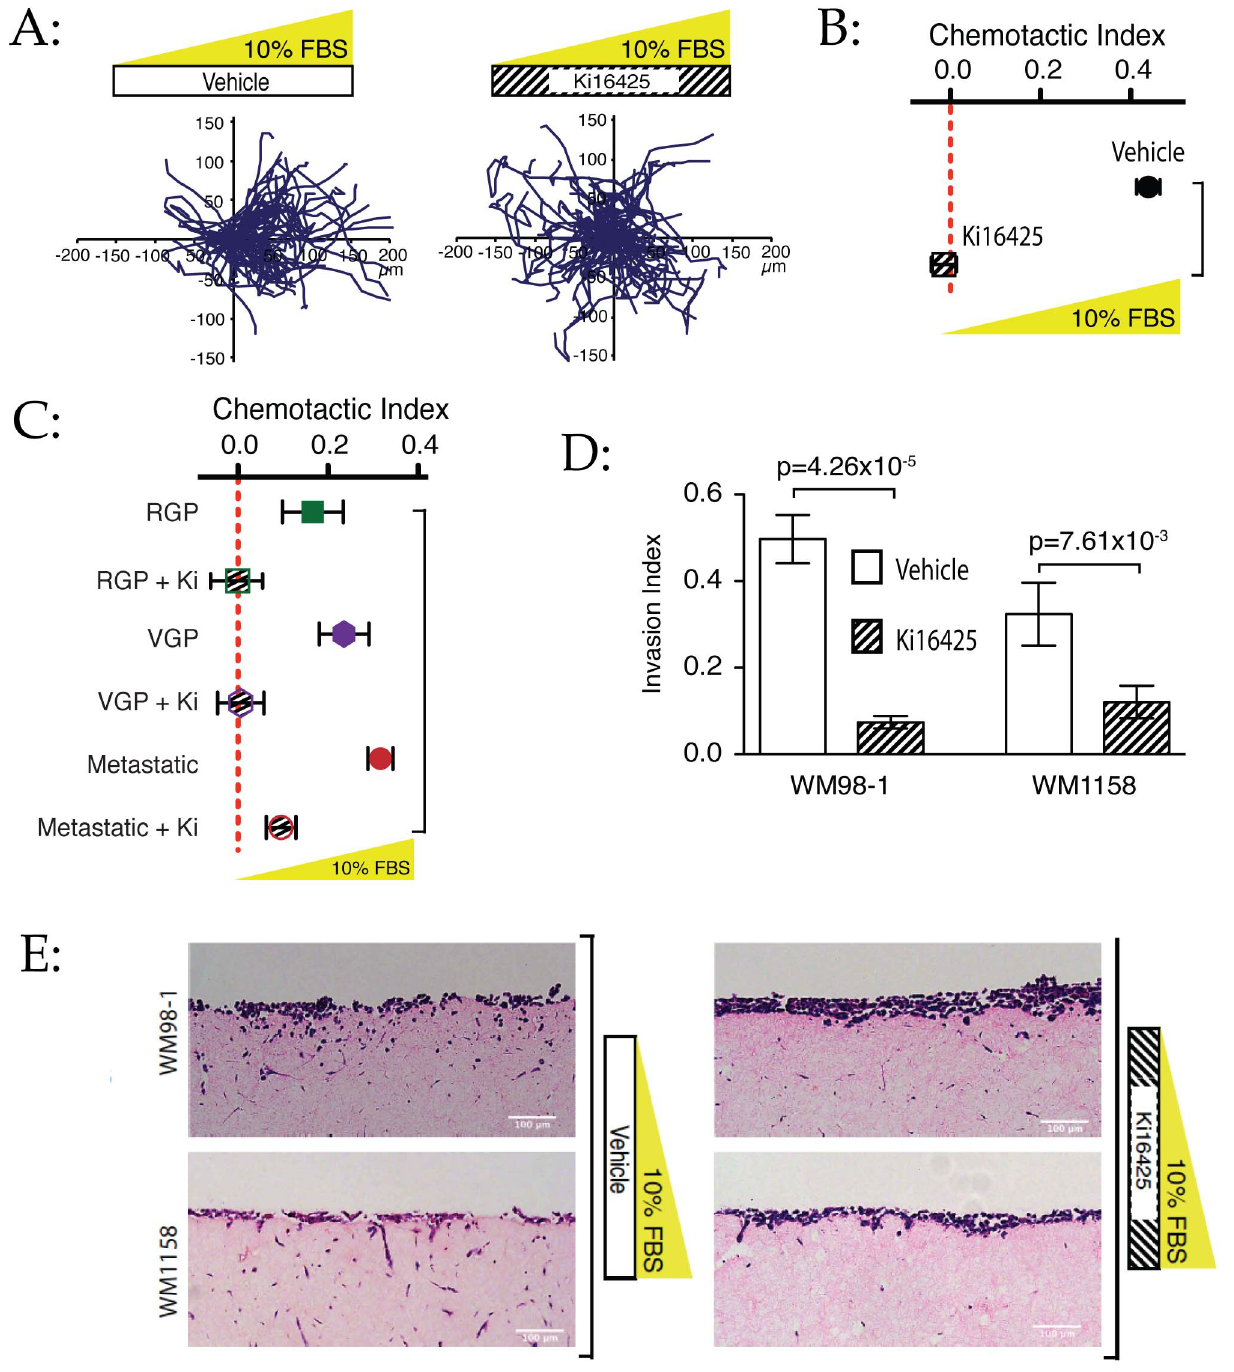
Figure 5. LPA responses are essential for serum chemotaxis in 2-D and 3-D assays. (A) LPA receptor antagonist Ki16425 blocks chemotaxis to serum. Chemotaxis of WM239A cells was compared with and without 10 m M Ki16425. Inhibitor-treated cells showed no chemotaxis despite essentially normal random migration. (B) Quantitative analysis of Ki16425 activity. Data from three experiments, including the one in (A). The chemotactic index of inhibitor-treated cells is essentially zero. (C) Melanoma cell lines from all stages chemotaxing up a 10% serum gradient with and without Ki16425. Colours represent melanoma stage. In RGP and VGP cells, chemotaxis is totally blocked, while in metastatic lines it is substantially inhibited. Bars show SEM. (D–E) 3-D organotypic assays. The cell lines WM98-1 and WM1158 are shown 6 Ki16425. LPA receptor antagonist greatly inhibits invasion. In (D), invasion index is calculated as the percentage of total cells on the organotypic matrix that invaded beyond , 30 m m as a ratio of cells on top of the matrix ( n . 1,000 cells per condition). (E) shows haematoxylin and eosin-stained vertical sections through gels, showing downward invasion of melanoma cells.